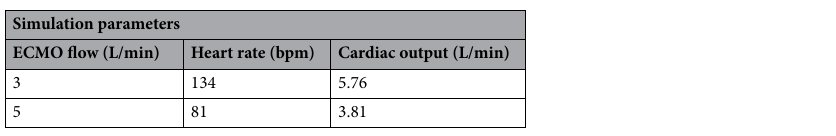
Table 1. The parameters used in our simulations